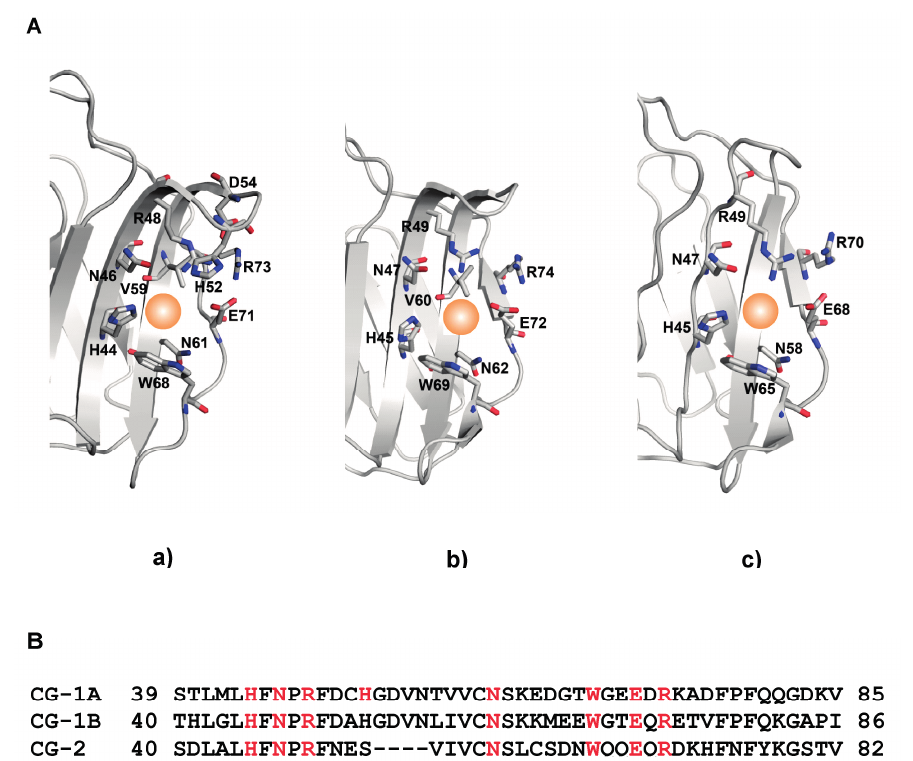
Figure 5. Comparison of the carbohydrate-binding sites ( A ) of the proto-type chicken galectins CG-1A ( a , PDB code 1QMJ), CG-1B ( b , PDB code 3DUI) and CG-2 ( c ,